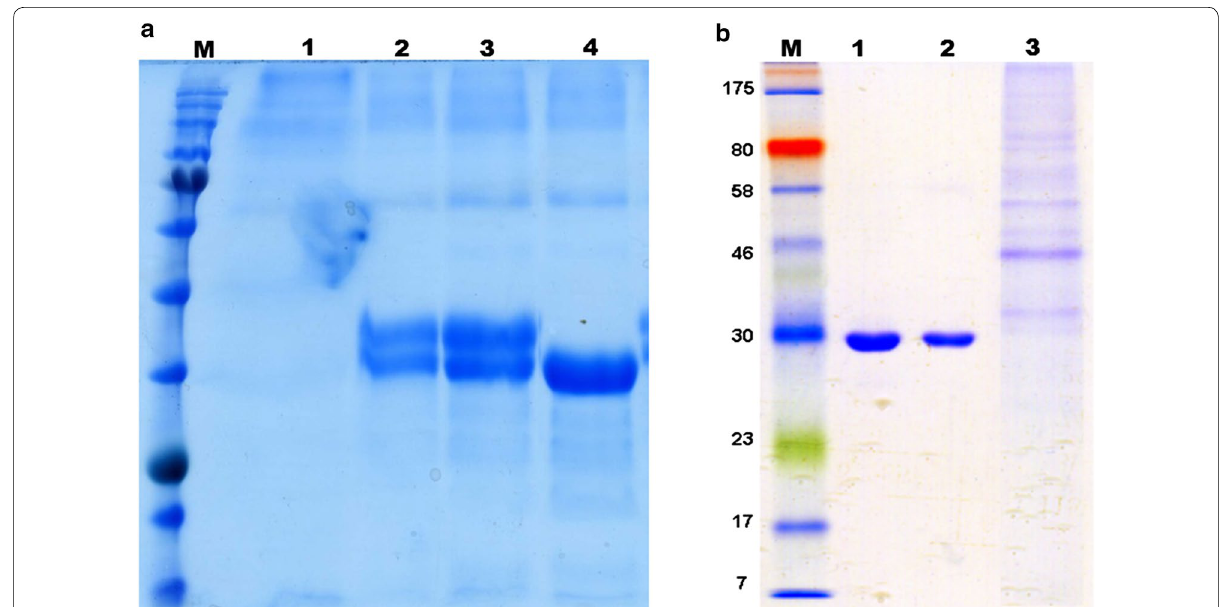
Fig. 3 SDS‑PAGE analysis of the extracellular extract from recombinants; a lane 1 X‑33/wild‑type, lane 2 X‑33/pGAPZα